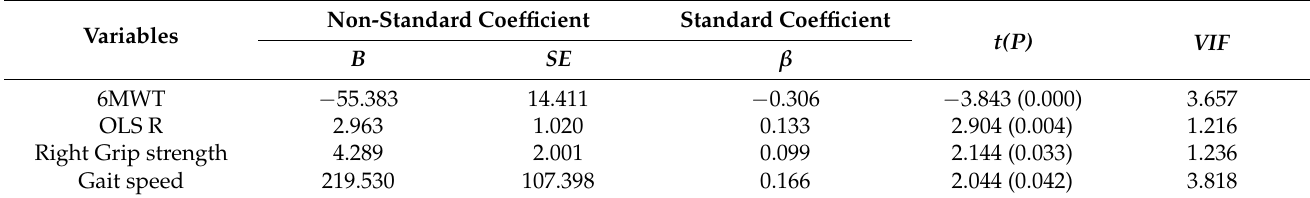
Table 6. Association between fall risk factors and balance confidence ( n =